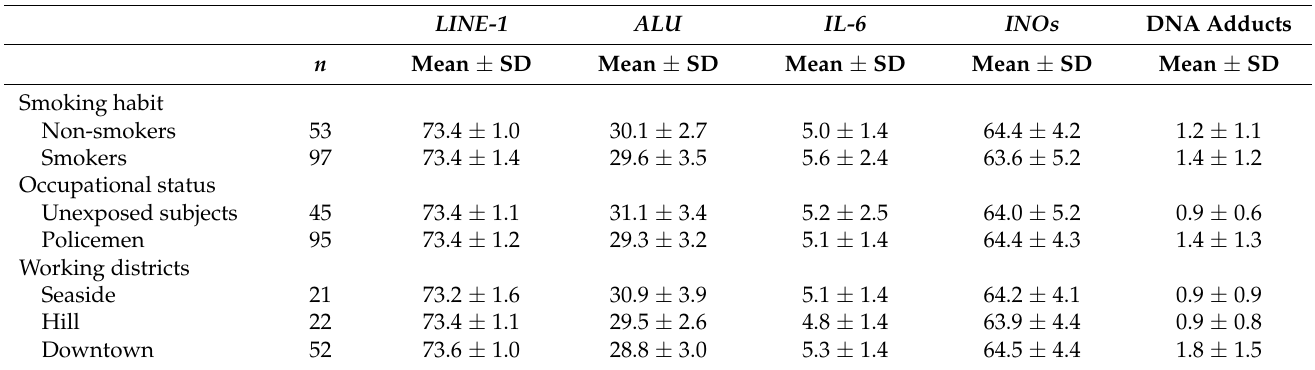
Table 2. Average levels of DNA methylation in the repetitive elements of the Long Interspersed Nuclear Element-1 ( LINE-1 ) and ALU , and in the promoter domains of the interleukin-6 ( IL-6) and the inducible nitric oxide synthase (i NOS) genes, expressed as a percentage of 5-methylcytosine, and the mean frequency of bulky DNA adducts, expressed as relative adduct labelling × 10 8 normal nucleotides, according to the smoking habit, exposure status and three working suburbs of Genoa, Italy (seaside, hill, and downtown).